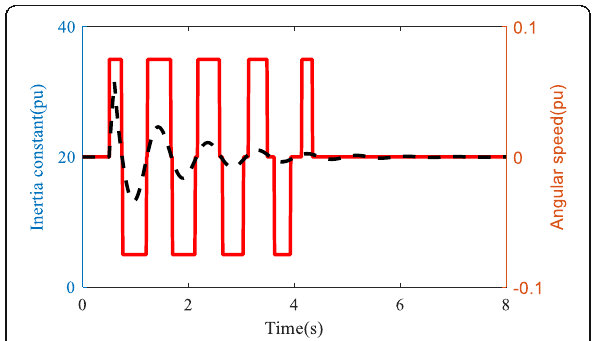
Fig. 14 The Virtual inertia of the PV-VSG when the output power of the PV is 0.09 pu